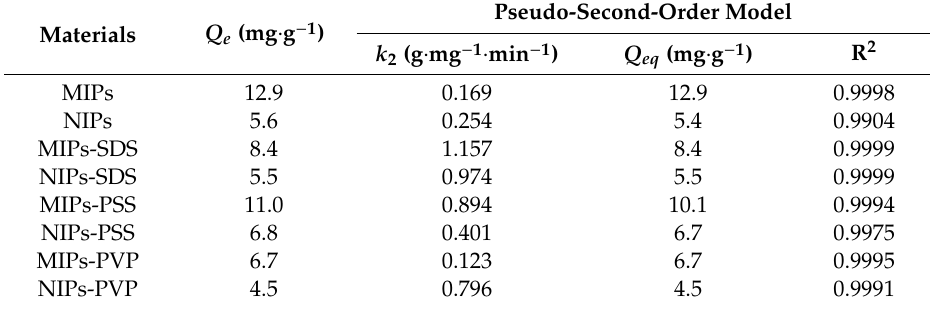
Figure 5. ( A ) Adsorption kinetics curves and ( B ) pseudo-second-order fitting curves for the molecular imprinted polymers (MIPs) prepared using different surfactants. (a) MIPs, (b) MIPs-PSS, (c) MIPs-SDS, (d) MIPs-PVP, (e) non-imprinted polymers (NIPs)-PSS, (f) NIPs-SDS, (g) NIPs, and (h) NIPs-PVP. PSS = poly(sodium-p-styrene sulfonate), SDS = sodium dodecyl sulfate, PVP = polyvinyl pyrrolidone. Table 1. Kinetics parameters for methylene blue adsorption by the molecularly imprinted polymers (MIPs) and non-imprinted polymers (NIPs) prepared using different surfactants (sodium dodecyl benzene sulfonate (SDBS), sodium dodecyl sulfate (SDS), poly(sodium-p-styrene sulfonate) (PSS), and polyvinyl pyrrolidone (PVP)).